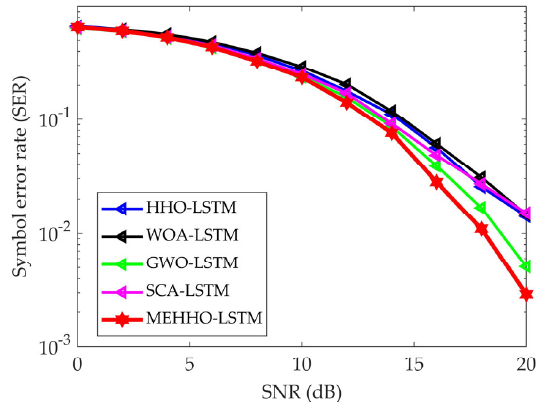
Figure 8. Comparison of the performance of the network model optimized by five algorithms.